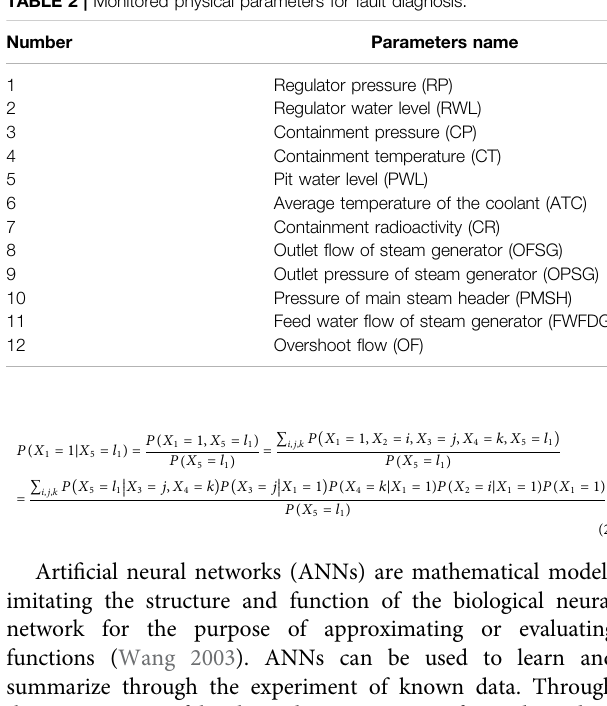
TABLE 2 | Monitored physical parameters for fault diagnosis.